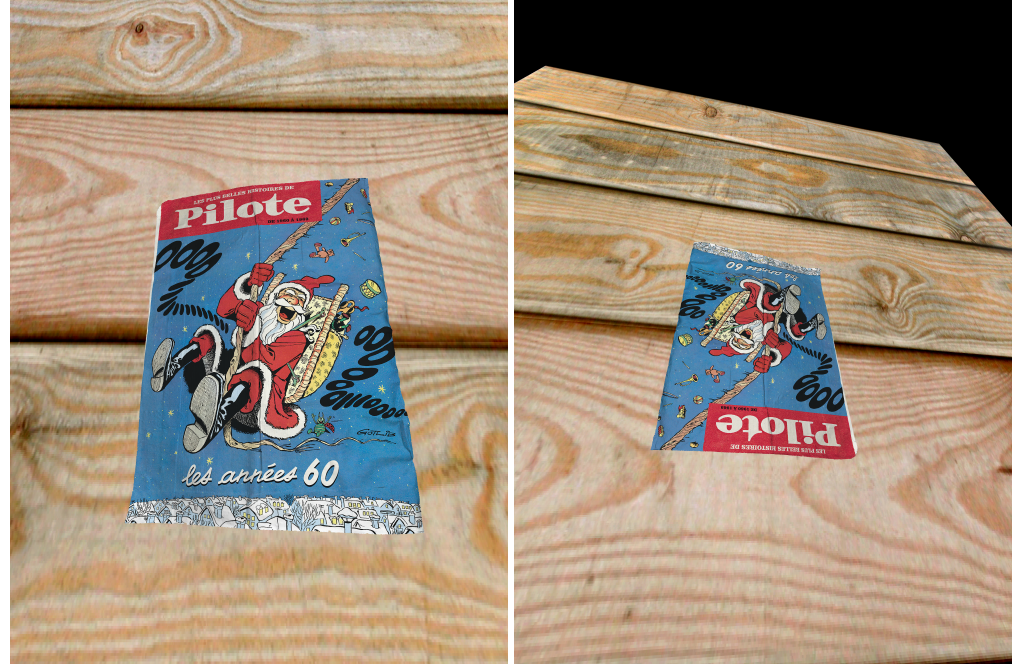
Figure 9. Examples of two viewpoints of the same document image, that could be used in the context of camera-based document image